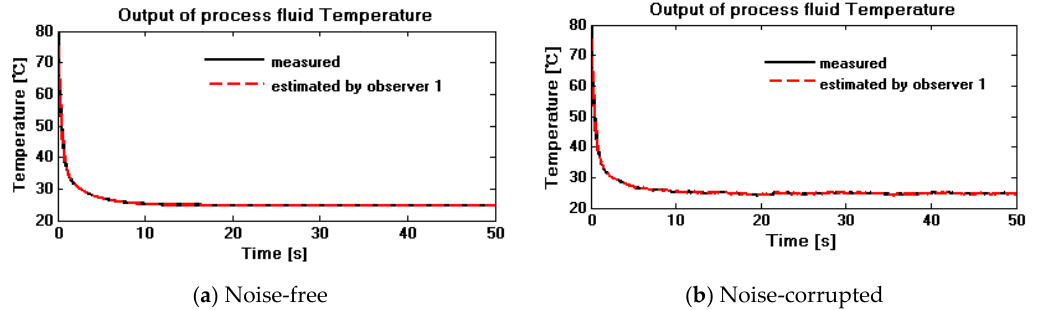
Figure 3. Output of the process fluid temperature T p . The solid line is the measured value, and the dashed line is estimated by Observer 1. ( a ) represents Noise-free case while ( b ) represents Noise-corrupted